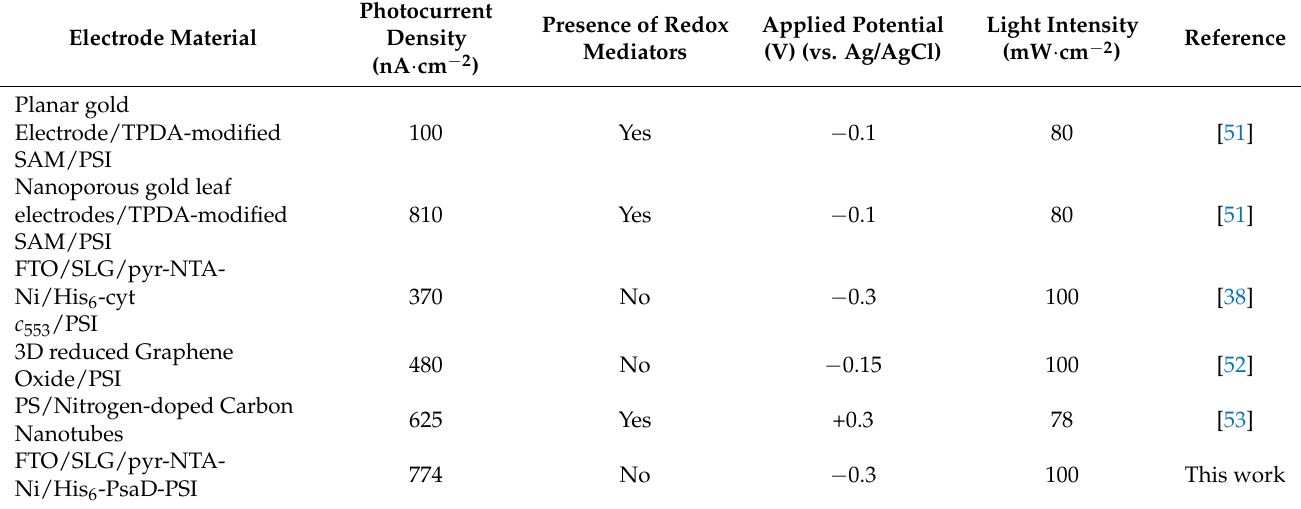
Table 2. Comparison of photocurrent densities of PSI-based bio-hybrids